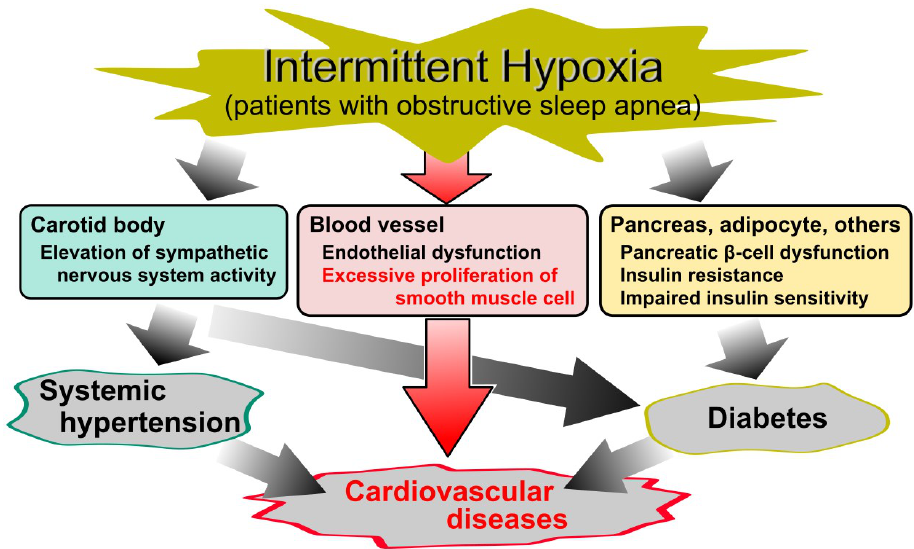
Figure 1. Cause and effect diagram of obstructive sleep apnea (OSA)-related diseases. Although intermittent hypoxia (IH) in OSA is a known risk factor for diabetes, systematic hypertension, and cardiovascular diseases, the cellular mechanisms underlying the relationship between IH and cardiovascular diseases remain elusive. Despite a large number of studies of IH, the molecular mechanism of IH on vascular smooth muscle cells is less established.